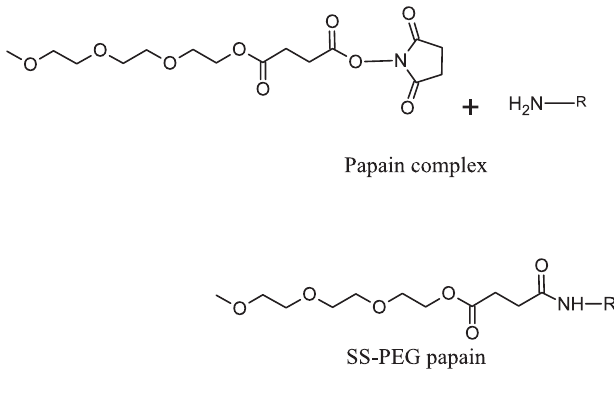
SCHEME 2 - Peglylation of